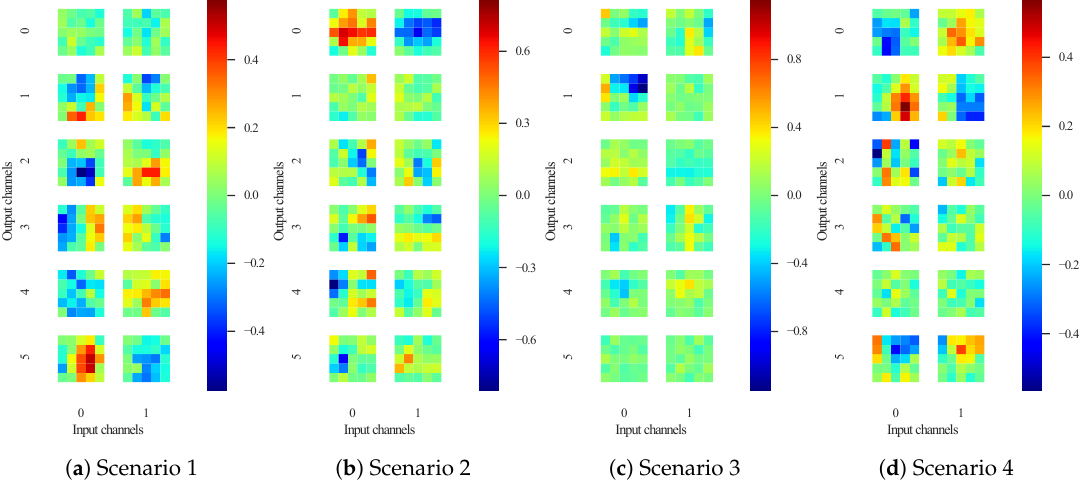
Figure 3. Visualization of filters in the first convolution layer. This figure illustrates six filters with two input channels. Some filters (e.g., the 5th output channel in Scenario 1 and the 0th output channel in Scenario 4) have contrasting values for the channels. This implies that the filters calculate the differences between the observed and background